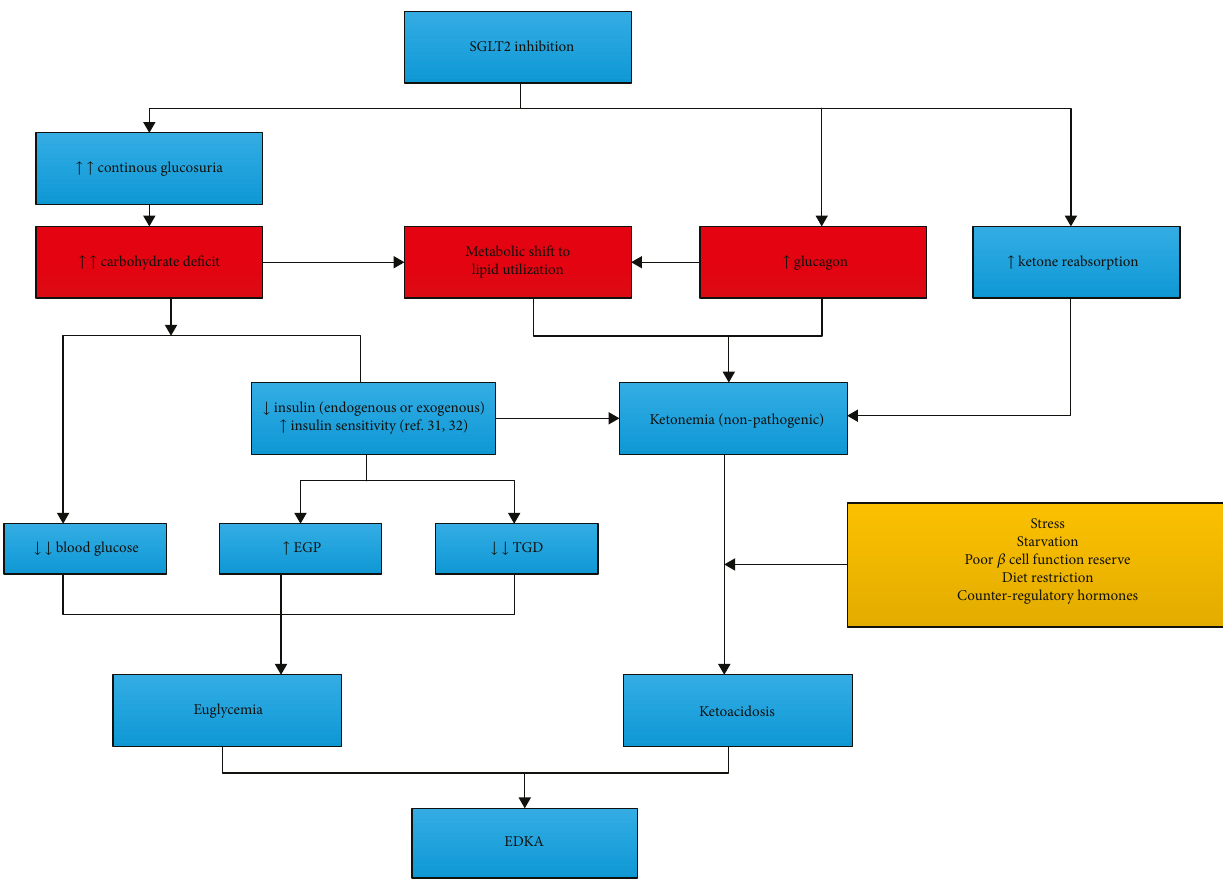
Figure 2: Pathogenesis of SGLT-2 inhibitor-associated EDKA. EGP: endogenous glucose production; TGD: tissue glucose